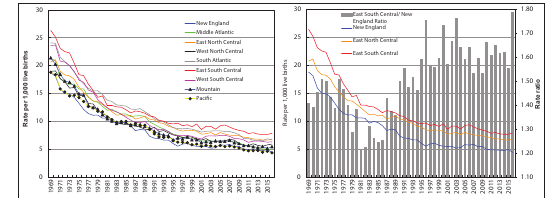
Figure 8 : Maternal educational gradients in infant and postneo- natal mortality by race/ethnicity, United States, 2016. Notes: Educational gradients in infant and postneontal mortality rates for each racial/ethnic group were statistically significant at p<.01 using trend t-tests. The postneonatal mortality rate for infants born to American Indian/Alaska Native mothers with a college degree is not shown because of small number of deaths (<10). Source: Data derived from the 2016 National Linked Birth/Infant Death Period File.